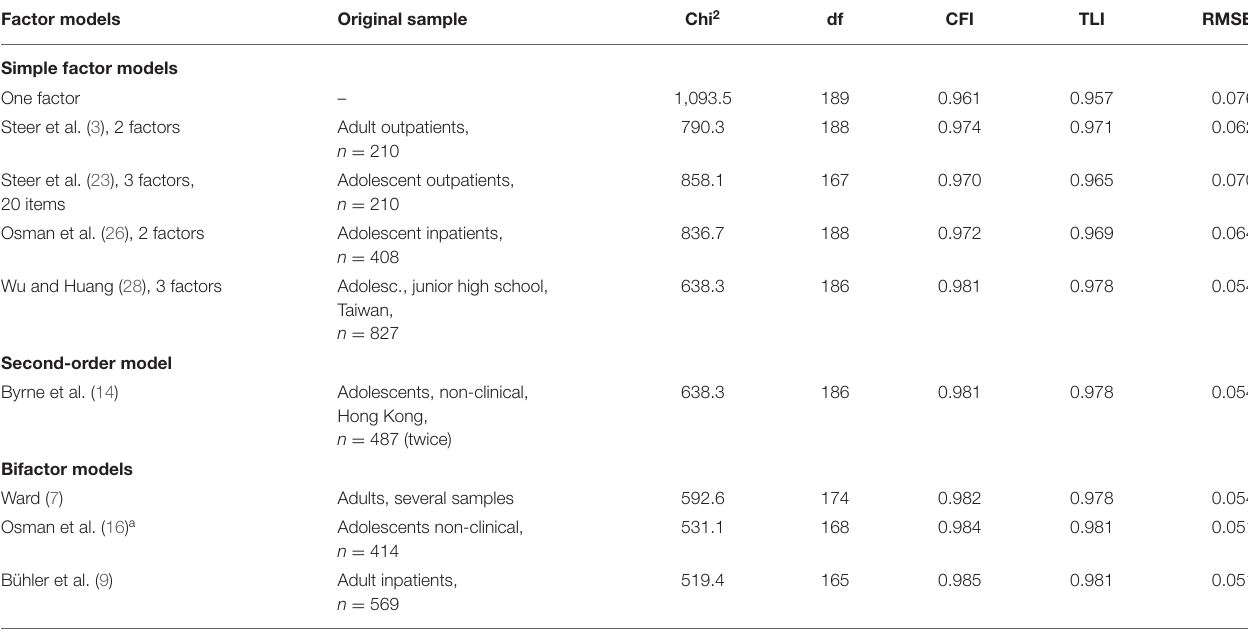
TABLE 2 | Confirmatory factor analysis: Fit indices of various factor models suggested in the literature applied to our